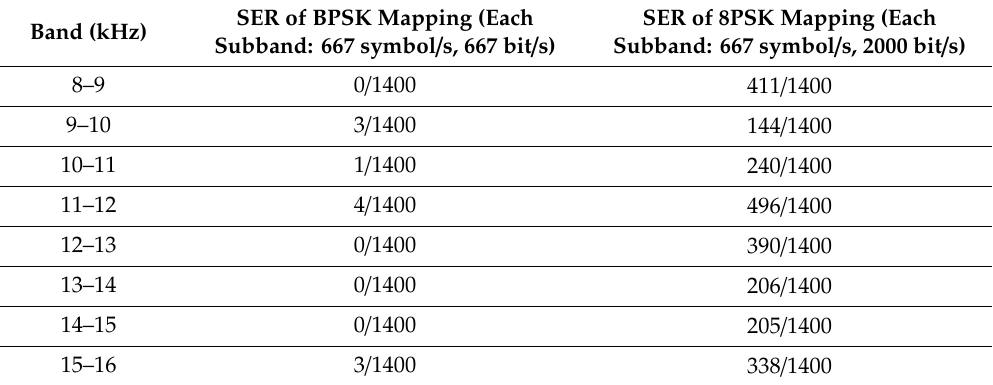
Table 4. Results of the method using traditional MMSE adaptive equalization.